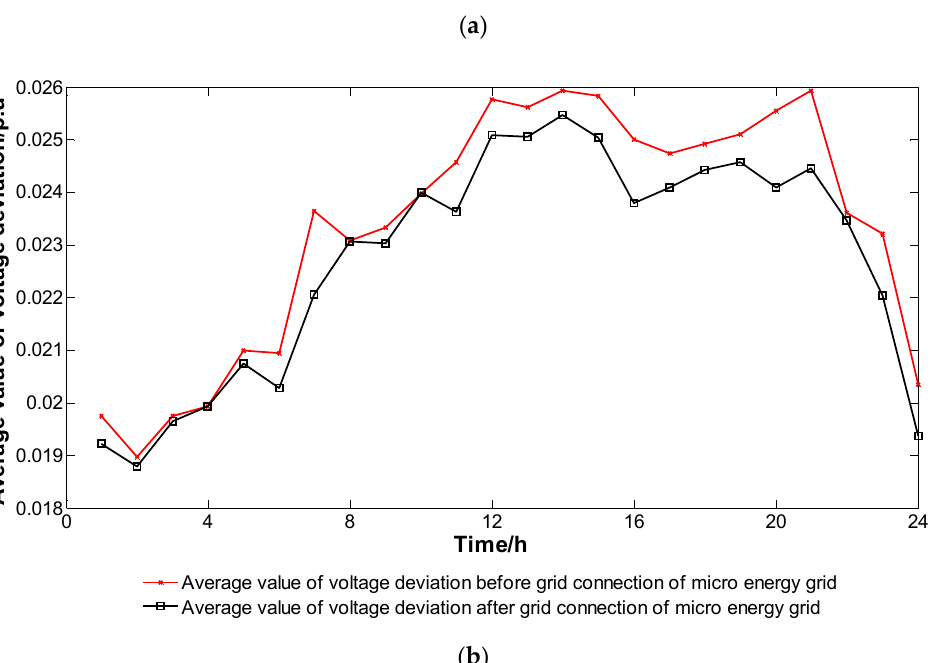
Figure 10. Comparison of the average voltage deviations before and after the grid connection of the micro energy grid on a typical day in the winter ( a ), and in the summer ( b ).